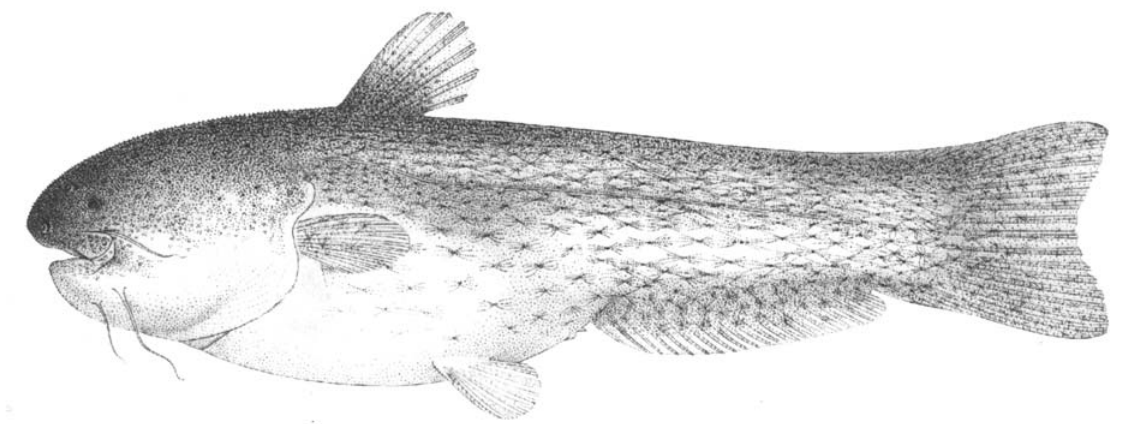
Fig. 49. Denticetopsis macilenta, original illustration of holotype of Hemicetopsis macilentus (Eigenmann, 1912b, pl. 23, fig. 1), showing distribution of pigmentation and form of horizontally-elongate, dark chromatophores on